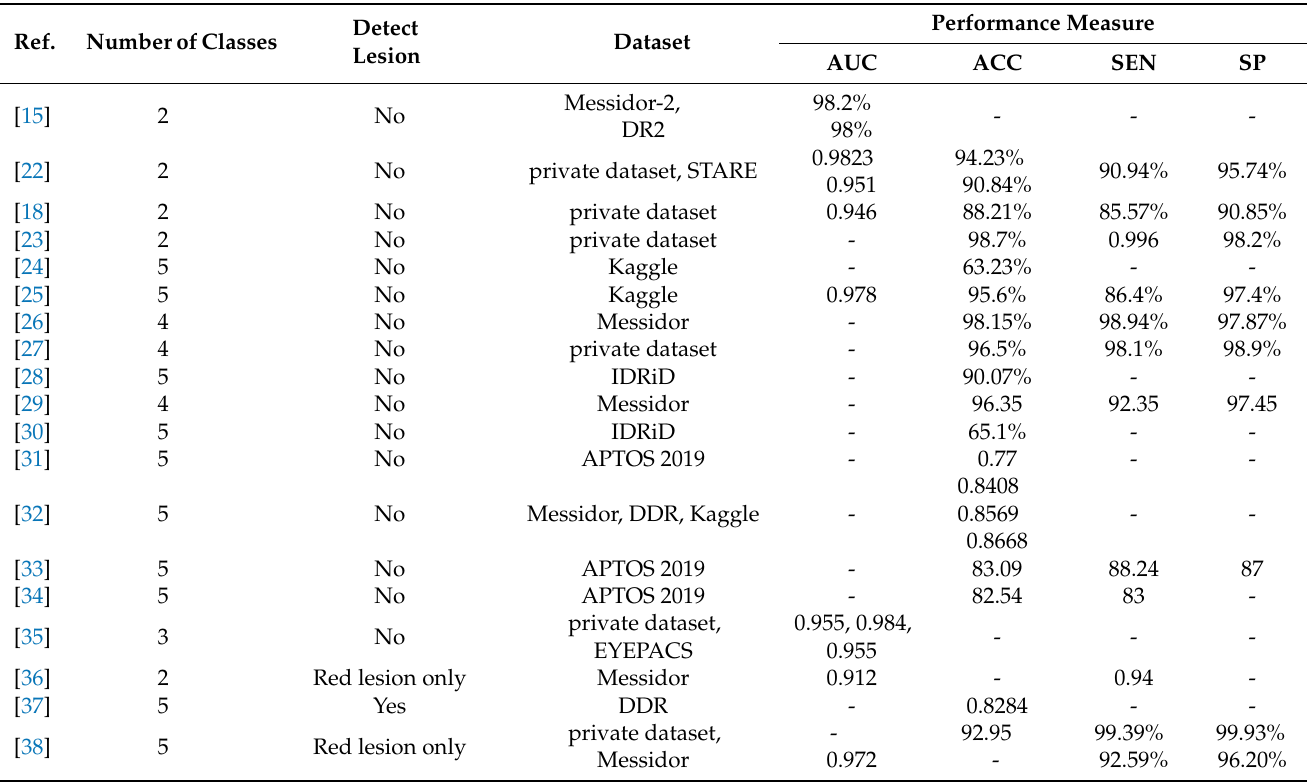
Table 2. Comparison between the related works that used DL to classify DR Images.